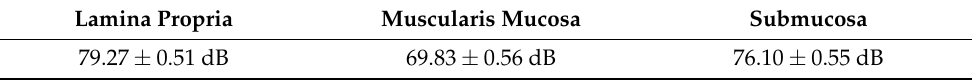
Figure 4. ( a ) OCT intensity values of different oesophageal tissue layer for each of the 52 samples. The OCT intensity is in dB scale. ( b ) OCT structure image, which the yellow dashed lines indicate the boundary between layers, from lumen side, top to bottom, the layers are Lamina propria, Mus- cularis Mucosa, and Submucosa respectively. Table 2. Averaged back-scattered OCT intensity from each oesophagus layer.